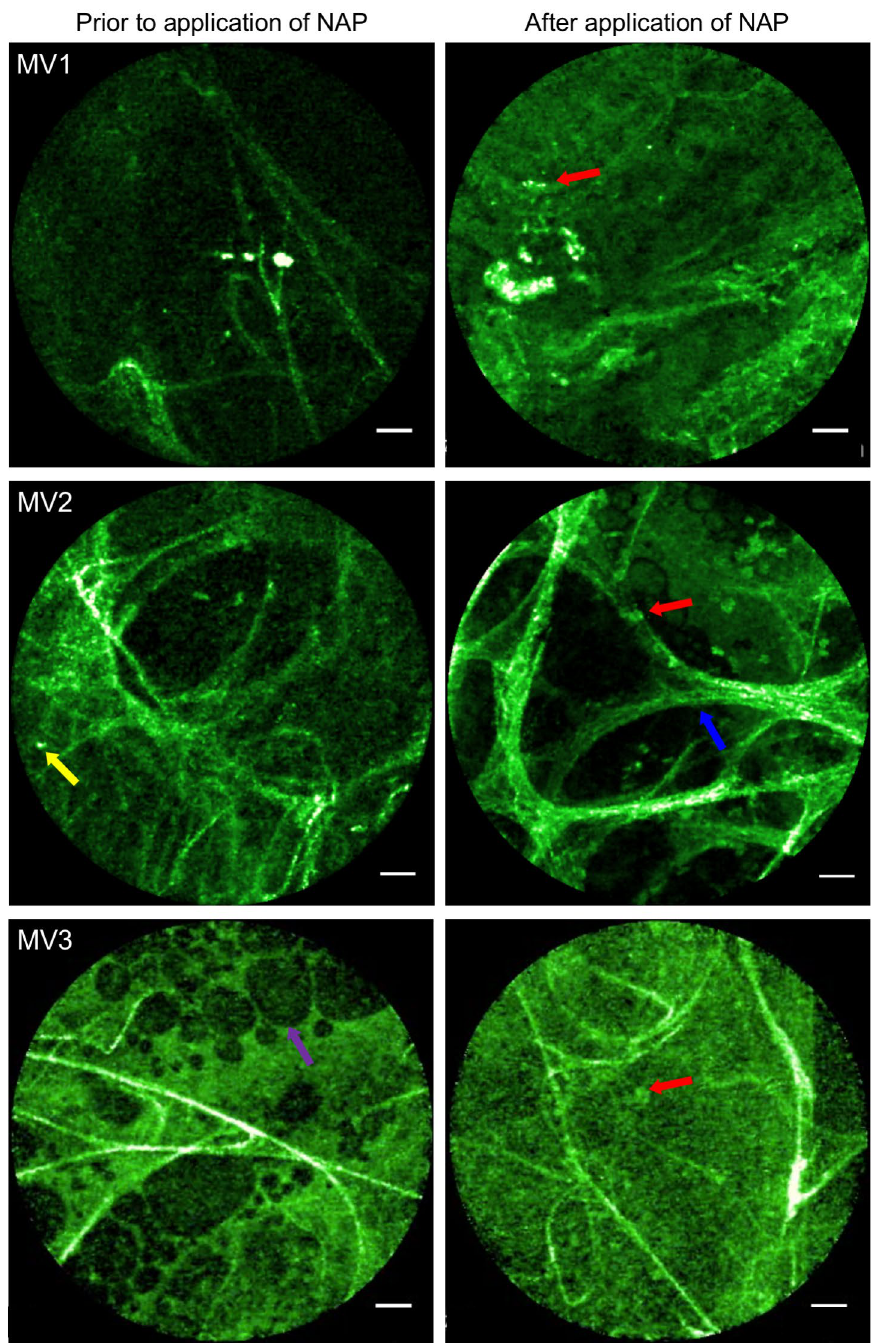
Figure 5. OEM from three mechanically ventilated (MV) patients. Each pair of images are representative from an individual study participant. Blue arrows—alveolar wall, red arrow—punctate fluorescent NAP signal, yellow arrow—autofluorescent cell, purple arrow—bubble of fluorescent fluid. The labelling of relevant features is not exhaustive in these representative